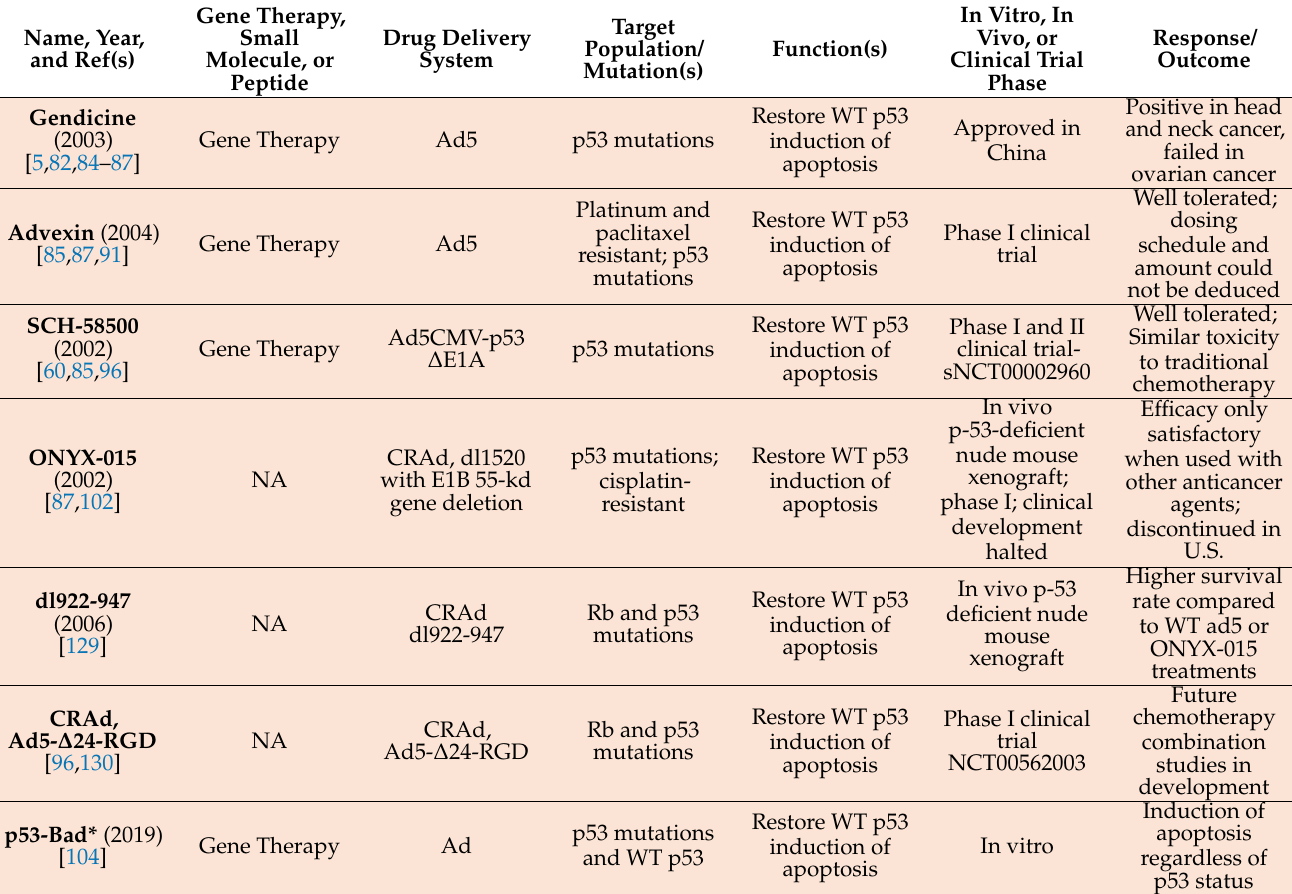
Table 1. Selected p53-based therapies for ovarian cancer. Orange = viral vectors; blue = nanoparticles; green = liposomes; purple = peptides; gray = small